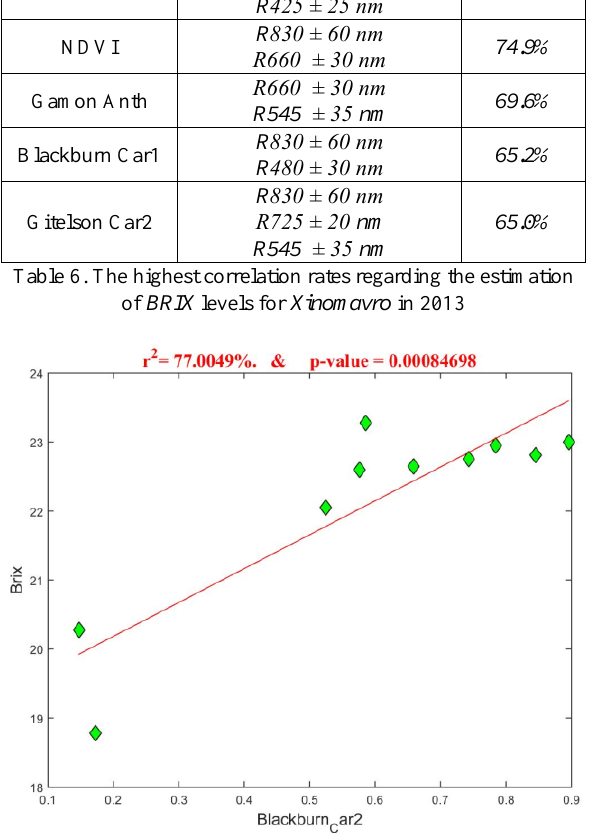
Figure 7. The highest correlation rate for the estimation of BRIX levels for the 2013 dataset in Naoussa was established with the Blackburn Car2